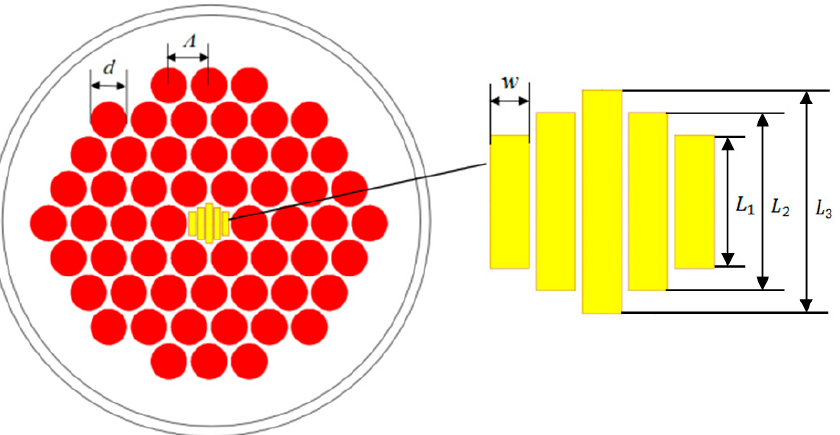
Figure 1. Cross-section of TOPAS ® -based THz sensor. The figure shows an enlarged view of the rectangular porous core of the sensor. The diameter of the cladding air hole of the TOPAS ® -based THz sensor is d, and the period is Λ . The width and length of the rectangular porous core are noted as w and L i (i = 1, 2, 3).